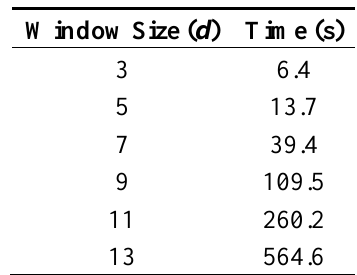
Table 3. Execution time (s) for one iteration of MH prediction for the Indian Pines dataset as a function of search-window size d .